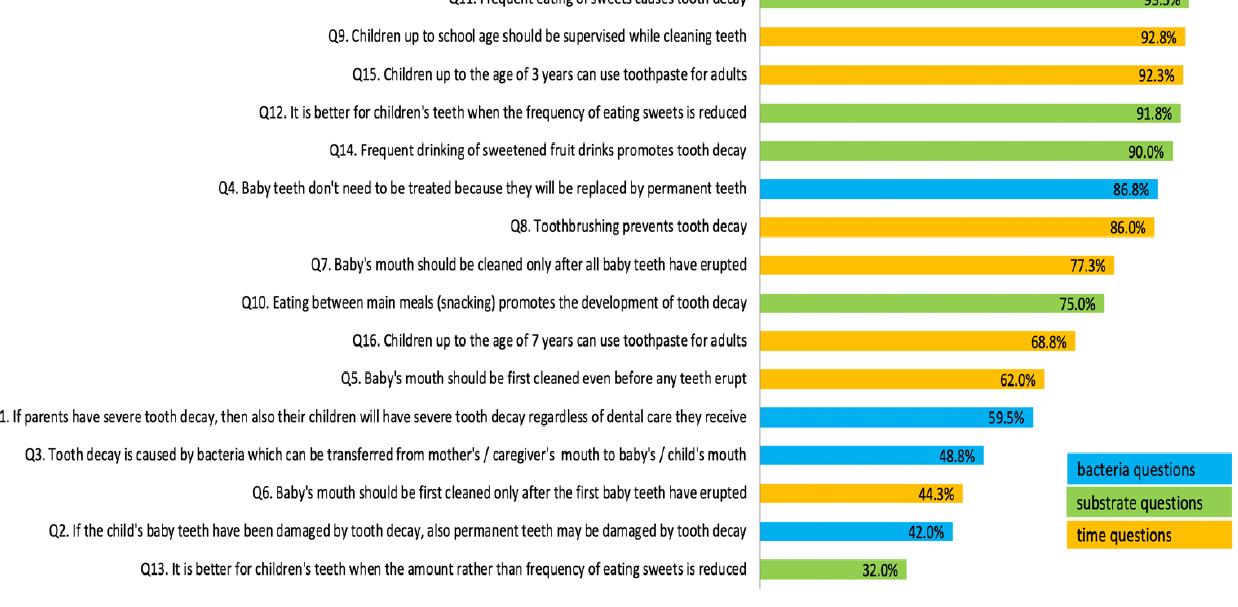
Figure 1. Percentages of correct answers to paediatric oral health knowledge questions